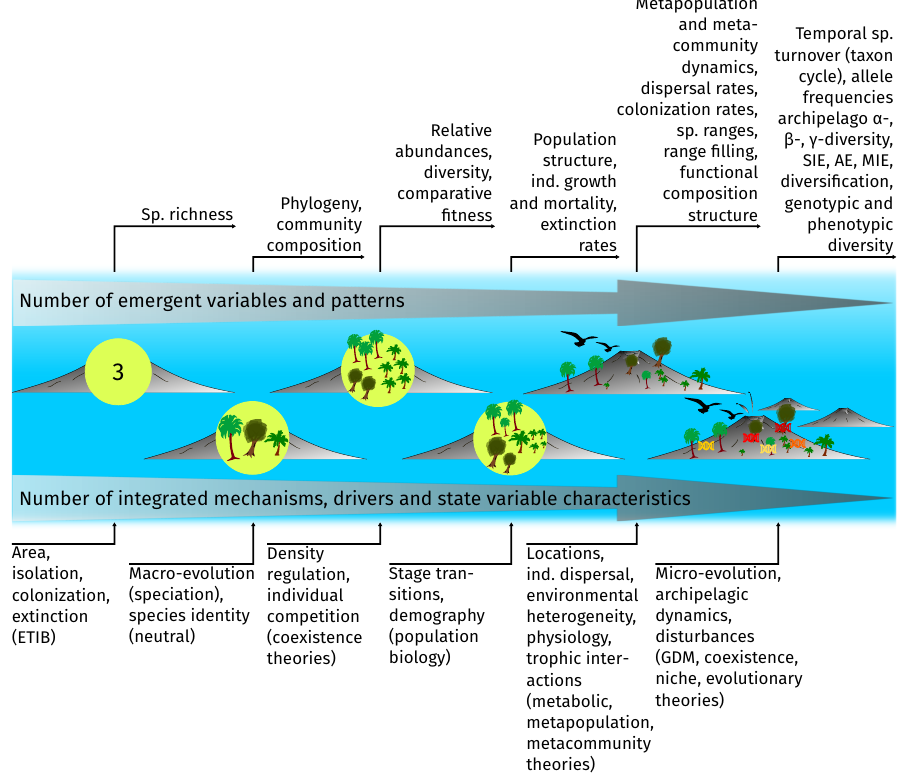
Figure 5. Representation of exemplary integrated processes and drivers in island models (bottom) and emerging variables and patterns (top). Model complexity, and thus generality [20], increases from left to right. We assume that processes and drivers add up from left to right. Thus, a given model representation includes also all processes and drivers of the less complex models to its left and is therefore also able to produce the respective patterns. Mechanisms and drivers are closely related to different theories (exemplary theories are shown in brackets at the bottom), e.g., colonization and extinction as the fundamental rates of the equilibrium theory of island biogeography (ETIB). As can be seen, some emergent patterns of more complex models are the same as the drivers for simpler models. For instance, the second model on the right produces colonization rates as an emergent pattern, which at the same time are necessary input parameters for the far left model. AE: archipelago endemics; ind.: individual. MIE: multiple island endemics; SIE: single island endemics; sp.: species; GDM: general dynamic